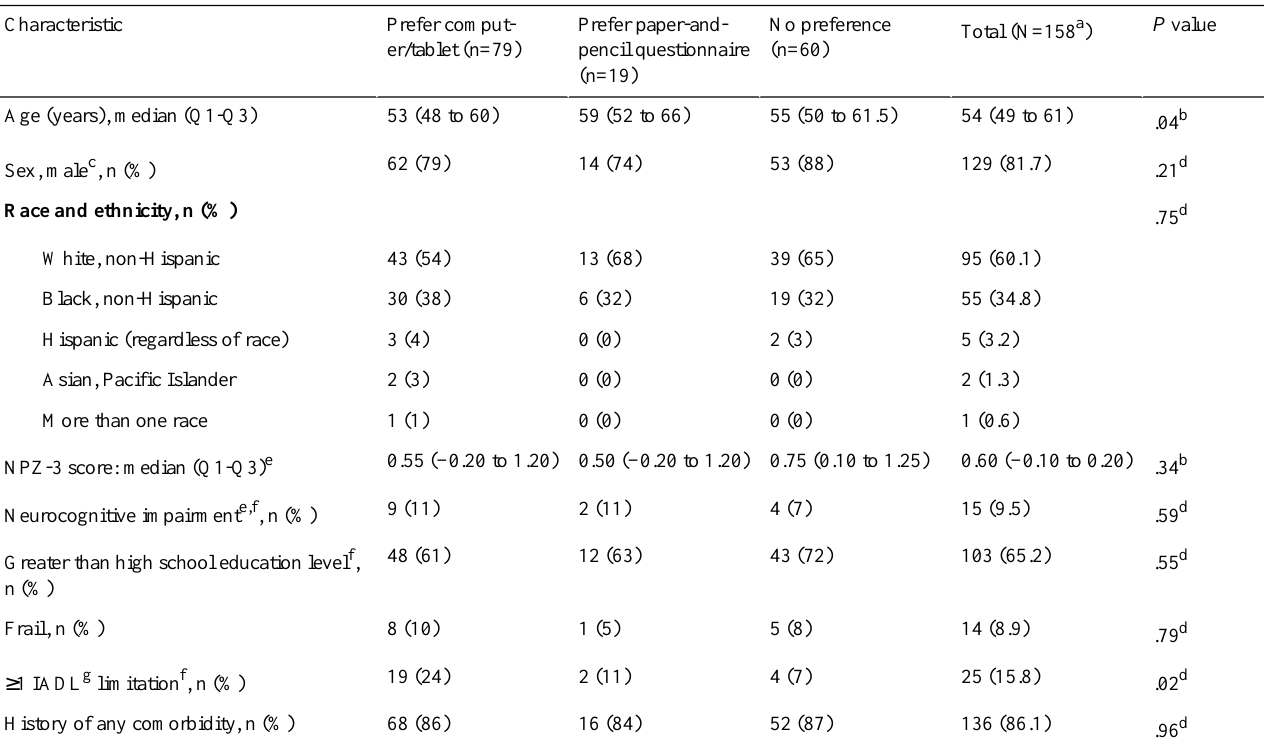
Table 1. Demographic and functional fitness by